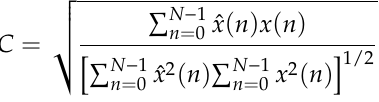
mm × 1 mm; ( d ) The diameter of through hole is 10 mm; ( e ) The diameter and depth of blind hole are 10 mm